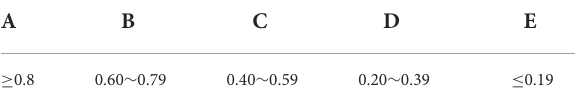
TABLE 1 Rank-sum ratio (RSR) comprehensive evaluation grade standard. A